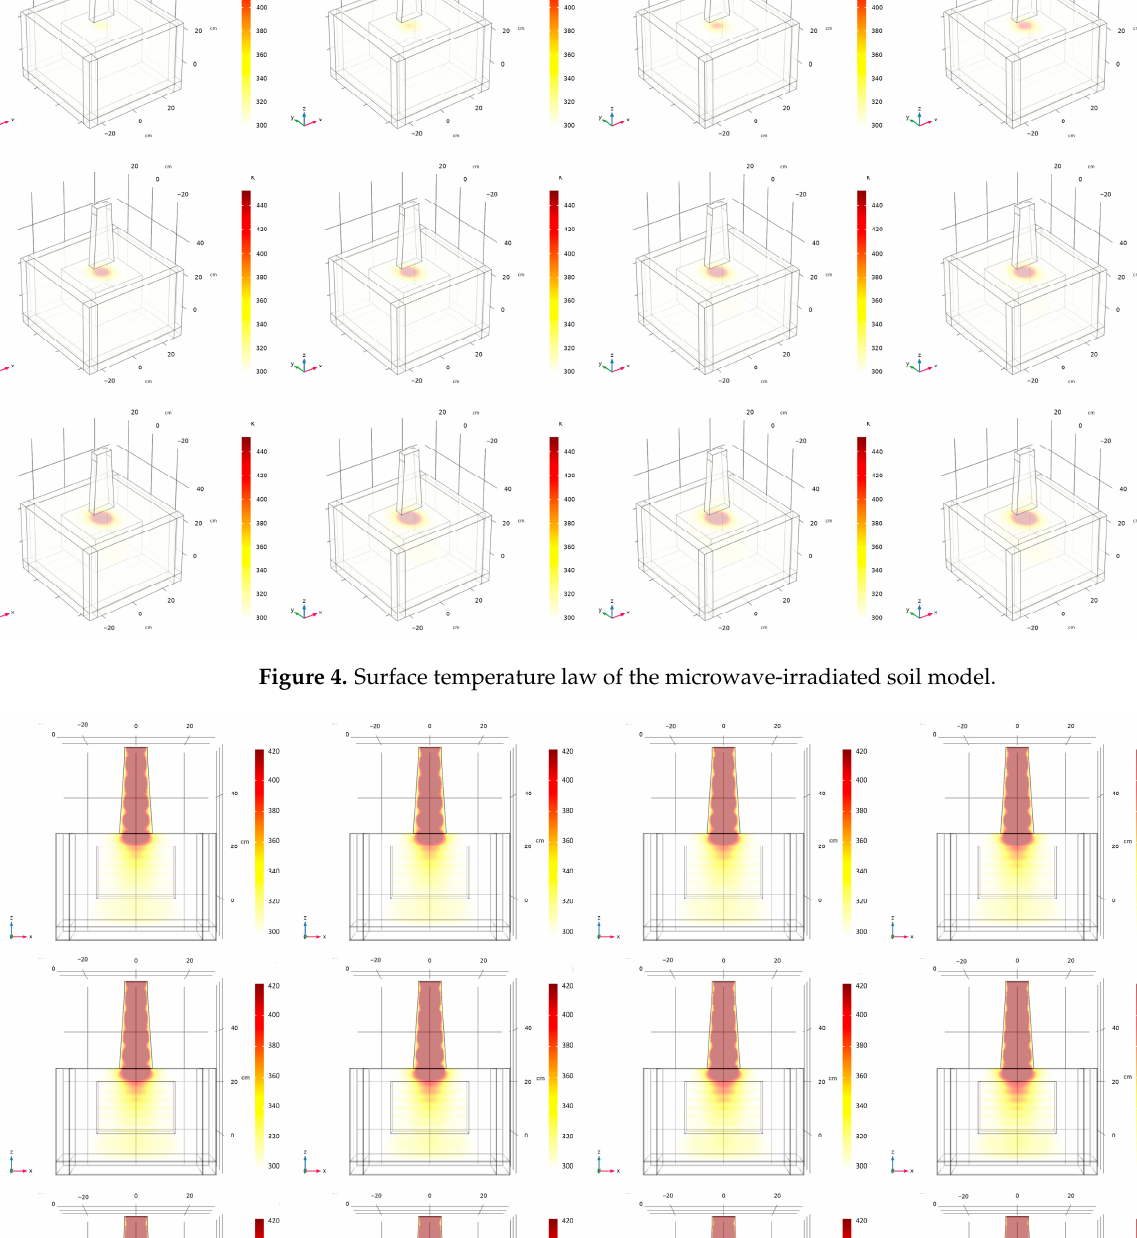
Figure 6. Acquisition of midline temperature values for the soil model. Figure 7. Soil model midline temperature plot. The simulation results after microwave irradiation for 5 min show that the maximum temperature inside the soil is 374.2 K, which meets the lethal temperature of most patho- genic bacteria, grass seeds and resistant plant viruses. Preliminarily, this shows the feasi- bility of long-term microwave irradiation in soil disinfection operations, but the simula- tion is carried out under ideal conditions by default. The soil has ideal characteristics, such